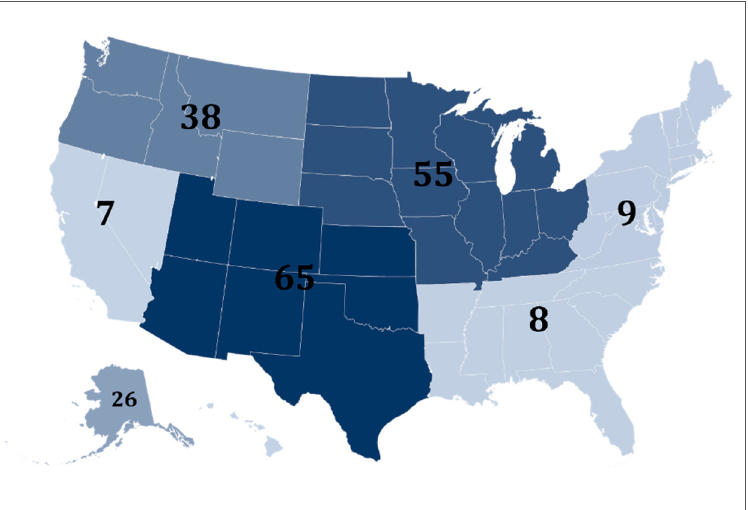
Figure 2. Location by Region of AIAN Communities Participating in Health-Related PR.